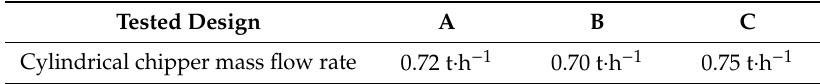
Table 6. Cylindrical chipper mass flow rate during tests, where A: carburettor fuel supply system; B: injector fuel supply system; C: injector fuel supply system equipped with an adaptive drive control